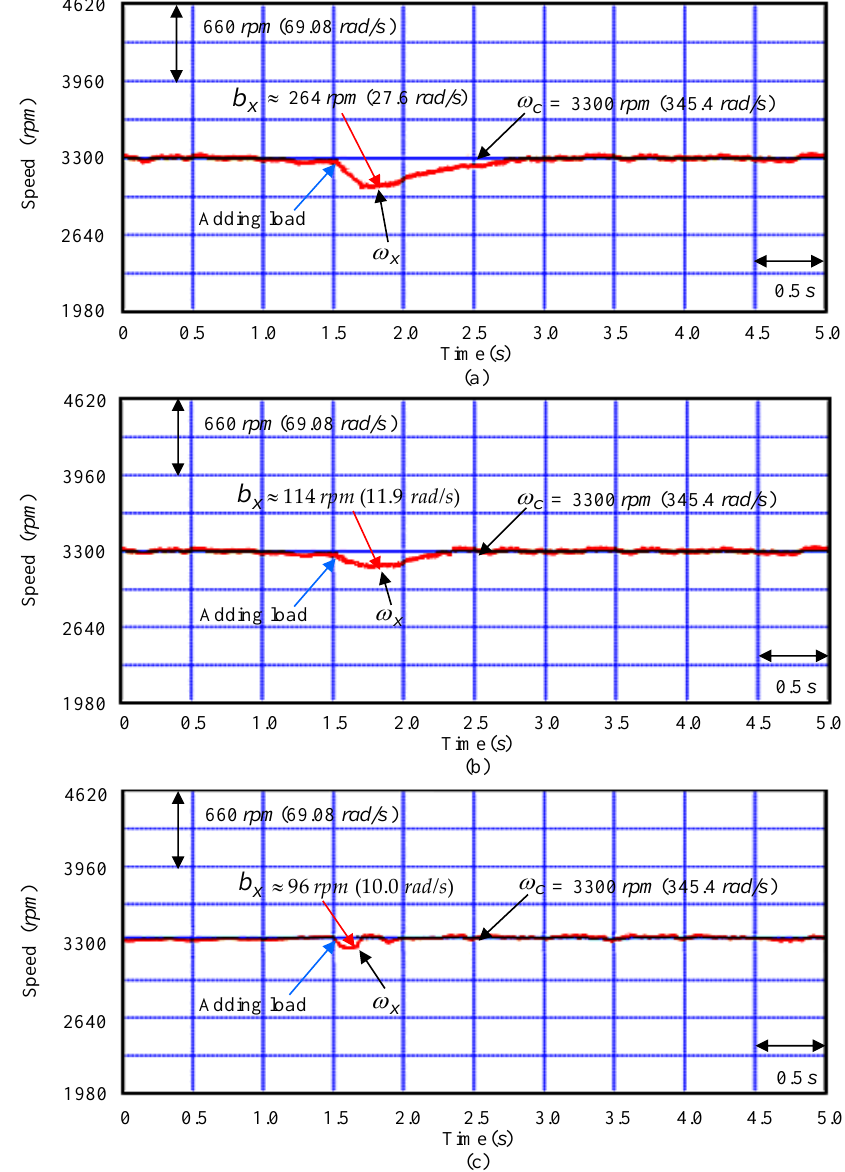
Figure 13. Tested instances with experimental results at the examination Y3 instance: ( a ) speed- regulated response obtained by using the controller CD1, ( b ) speed-regulated response obtained by using the controller CD2, ( c ) speed-regulated response obtained by using the controller CD3.